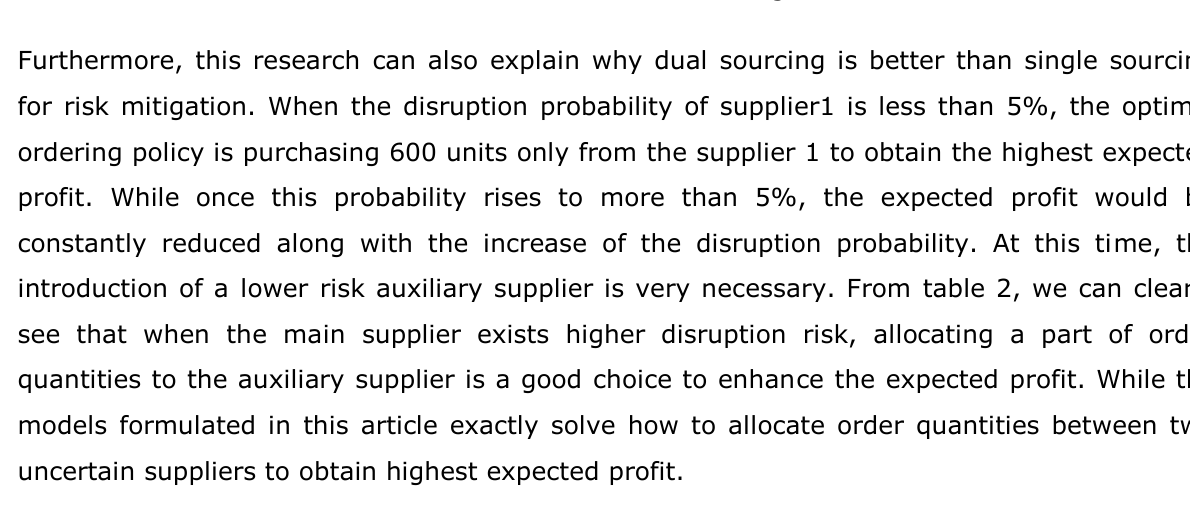
Table 2. contrast of decisions considering risks or